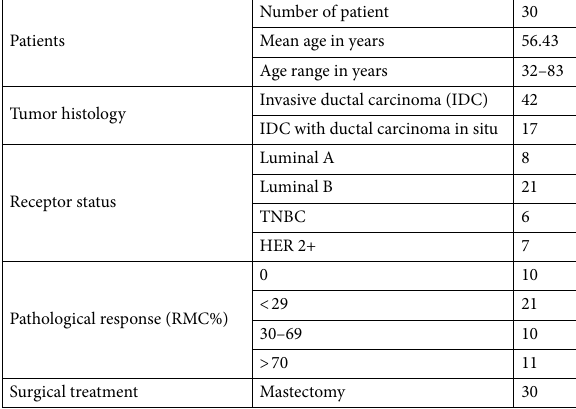
Table 1. Patient characteristics including histological findings.